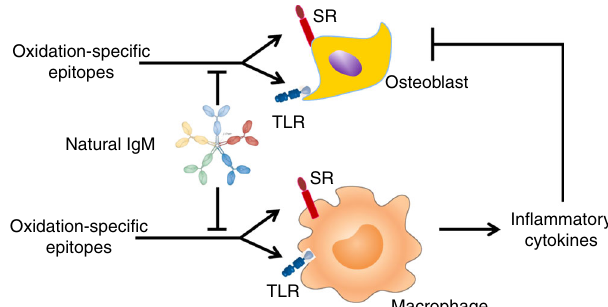
Fig. 7 Model for the anabolic effect of anti-OSE antibodies on bone. OSEs may directly inhibit the differentiation and survival of osteoblasts via scavenger receptor (SR) or toll-like receptors (TLR). OSEs may stimulate the production of anti-osteogenic cytokines via activation of these receptors on macrophages. Natural IgM that recognize OSEs may exert an anabolic effect by preventing their binding to SR and TLR of osteoblastic cells and /or